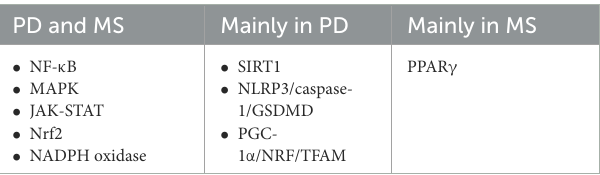
TABLE 1 Cell signaling pathways involved in PD and/or